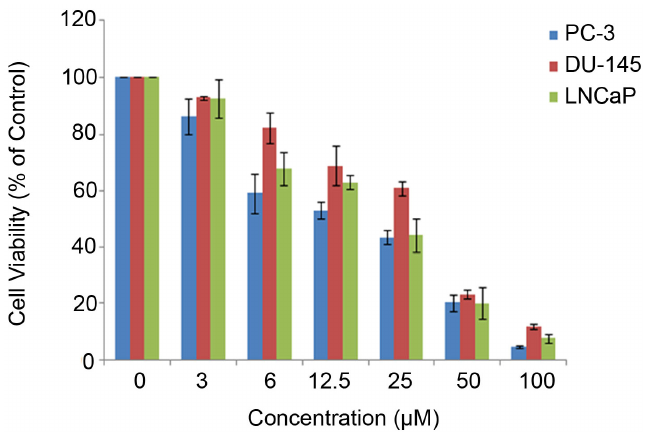
Figure 2. Isoalantolactone inhibited the cell growth and induced cell death in prostate cancer cells. LNCaP, PC-3 and DU-145 cells were treated with indicated doses of isoalantolactone in the presence or absence of NAC for 24 h and cell viability was measured by MTT assay. Data are expressed as Mean ± SD (n =